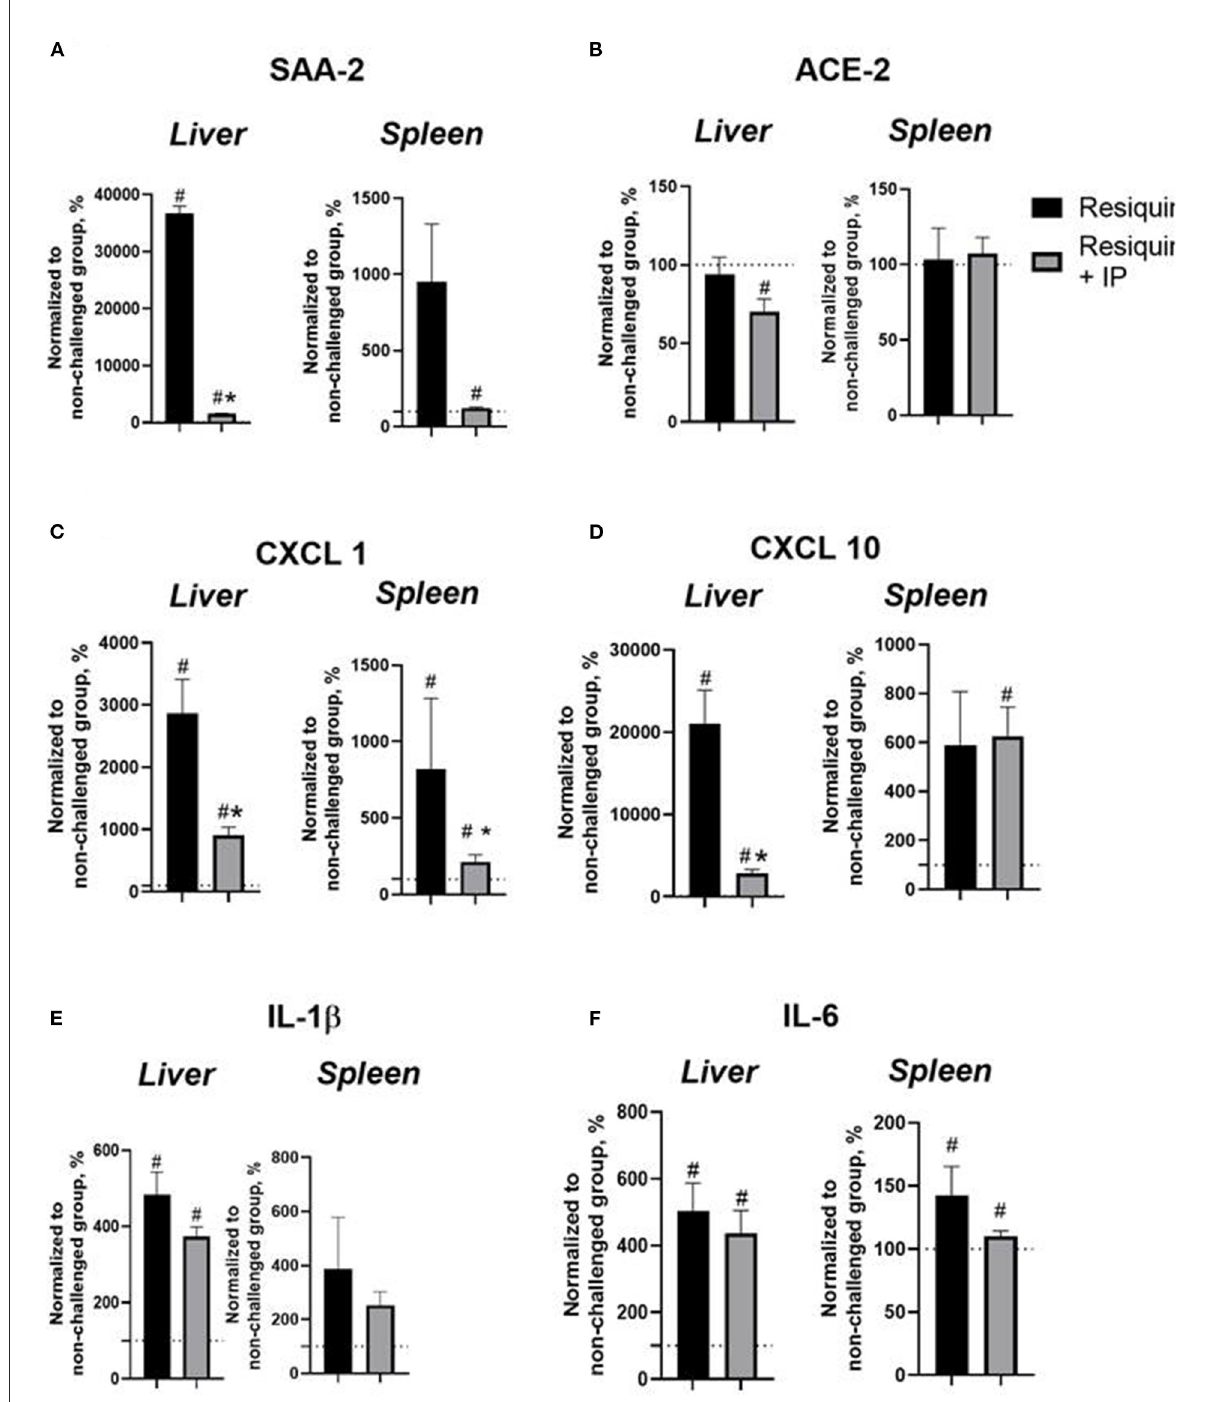
FIGURE2 Pro-inflammatory resiquimod-induced gene expression changes in the liver and spleen are ameliorated with the herbal IP treatment. (A) Resiquimod-challenged groups showed a significant increase in the normalized liver expression of SAA-2mRNA in comparison to a 100%-level. This measure was lower in the liver of IP–treated animals. No such differences were shown for the spleen. (B) As compared to a 100%-level, there was a significant decrease in the normalized ACE-2mRNA expression in the liver of the IP-treated group but not in the non-treated resiquimod-challenged mice that was not found for the spleen (C) Both resiquimod-challenged groups showed a significant increase in liver CXCL1mRNA normalized concentrations as compared to 100%; the IP-treated group subjected to the resiquimod injection had a significantly decreased normalized liver CXCL1mRNA expression compared with resiquimod-injected animals. In the spleen, compared to 100%, this